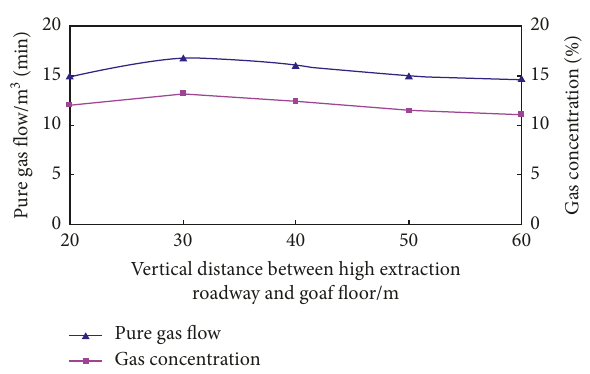
Figure 4: Extrication effect of the high extraction roadway under different horizontal distances between the high extraction roadway and the return air